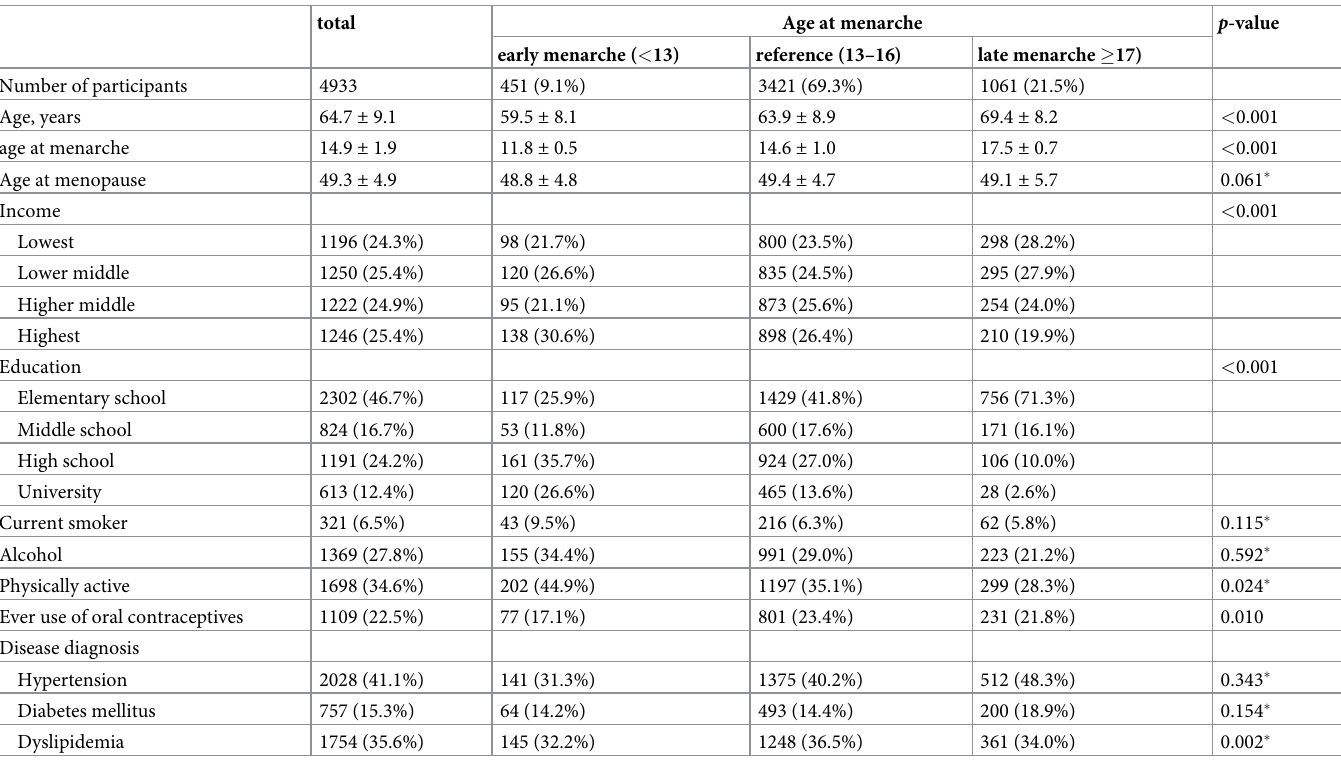
Table 1. Baseline characteristics of study participants by age at menarche. total Age at